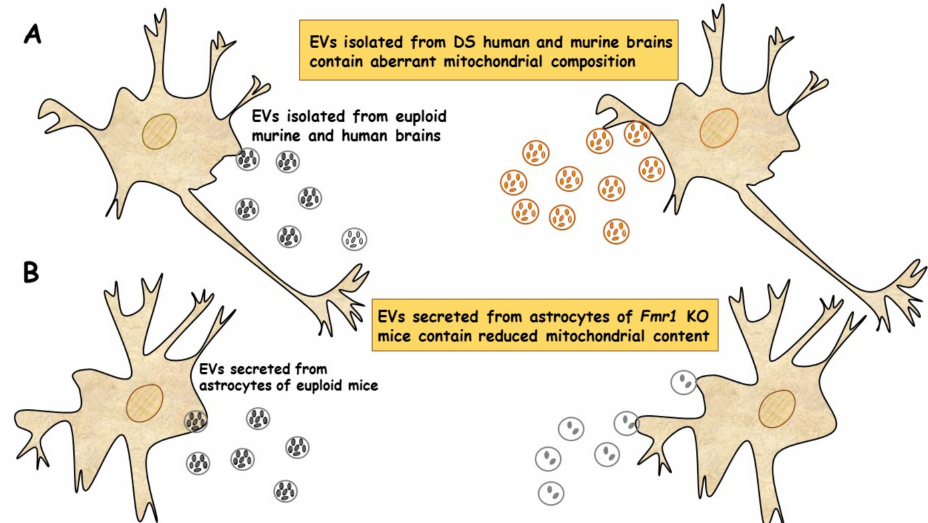
Figure 2. EVs of mitochondrial origin reflect mitochondrial dysfunction in DS and FXS. ( A ) Mitovesicles are a novel population of extracellular vesicles of mitochondrial origin altered in DS. Comparative analysis of EVs obtained from individuals with DS and Ts2 mouse model of DS showed higher numbers of mitovesicles with altered composition in the cerebral parenchyma, in both DS murine and human post-mortem brains [84]. ( B ) Depletion of mitochondrial components from extracellular vesicles secreted from astrocytes in a mouse model of FXS. Mitochondrial components contained in EVs derived from both cerebral cortices and astrocytes of Fmr1 KO mice were found reduced